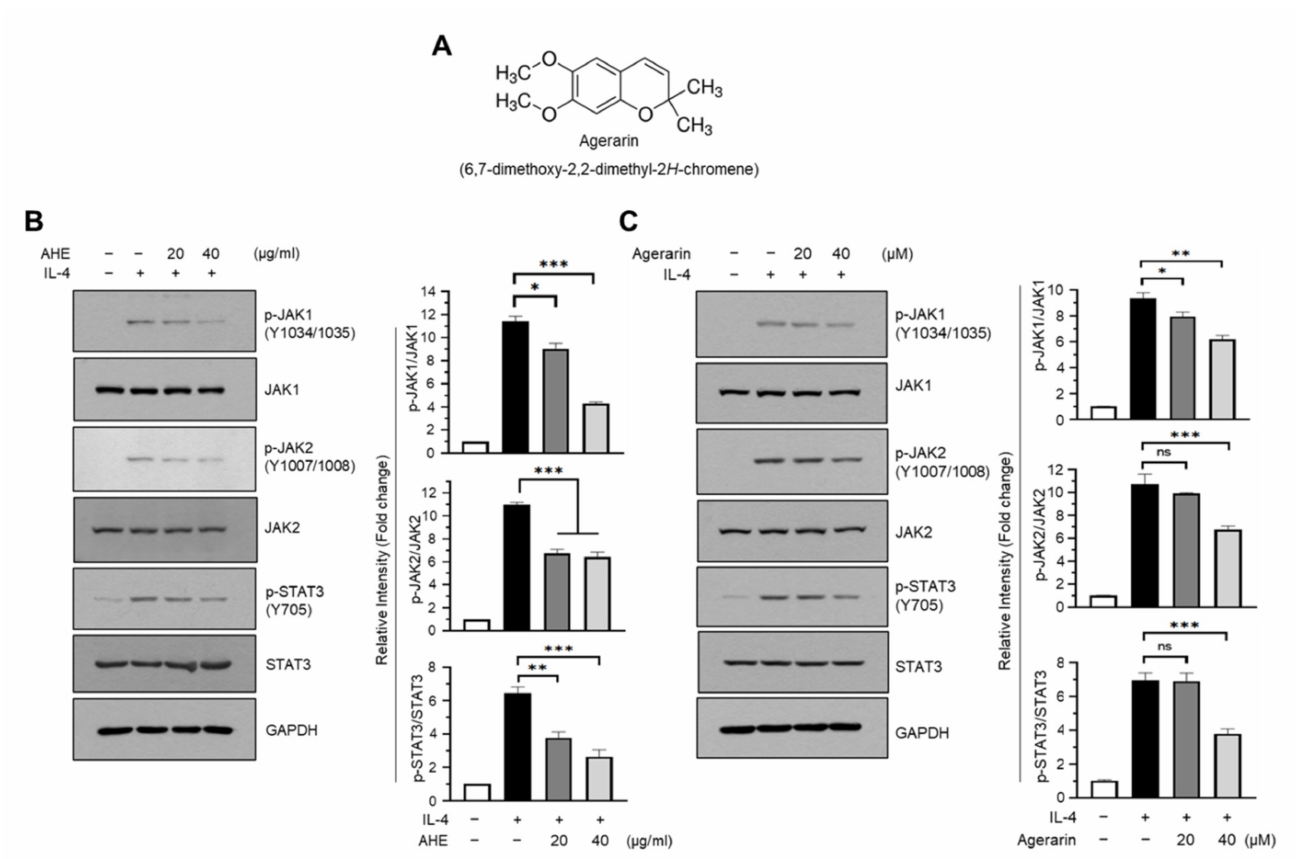
Figure 3. Effect of AHE and agerarin on inhibition of the JAK/STAT3 signaling pathway stimu- lated by IL-4. ( A ) Chemical structure of agerarin. ( B , C ) HaCaT cells were pretreated with 20 and 40 µ g/mL AHE ( B ) or 20 and 40 µ M agerarin ( C ) for 30 min before stimulation with (+) or without ( − ) 20 ng/mL IL-4. After 15 min, cells were harvested, and the phosphorylation of JAK1 at Y1034/1035, JAK2 at Y1007/1008, and STAT3 at Y705 were measured by immunoblotting. Band intensities of phosphorylated proteins were measured using ImageJ and normalized to the corresponding to- tal proteins. GAPDH was used as an internal control. ns, not significant; * p < 0.05, ** p < 0.01, *** p < 0.001 compared to control ( n = 3) by an unpaired two-tailed t -test. AHE, ethanolic extract of Ageratum houstonianum